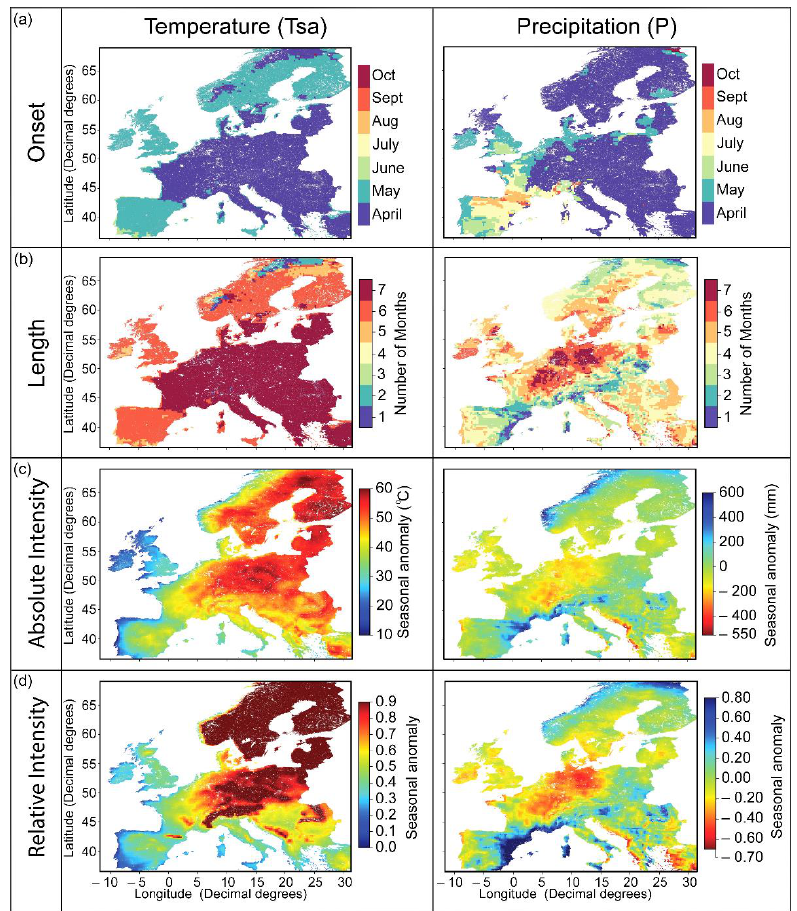
Figure 2. Characteristics of the Europe’s combined drought and heatwave in 2018. ( a ) Onset, ( b ) length, ( c ) absolute intensity and ( d ) relative intensity of surface air temperature (T sa ) and precipitation (P) anomalies in 2018.